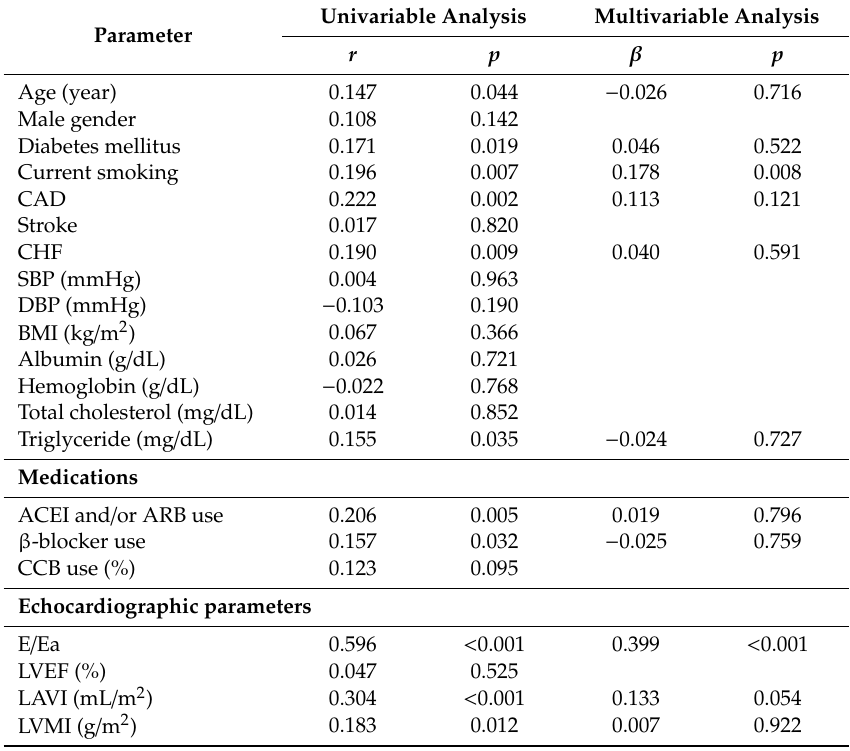
Table 3. Univariable and multivariable correlates of E / LA strain in study patients.